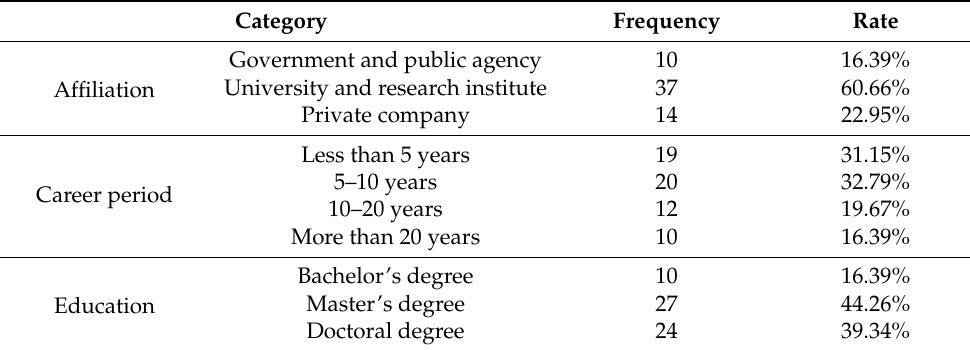
Table 5. Demographic characteristics of the sample.